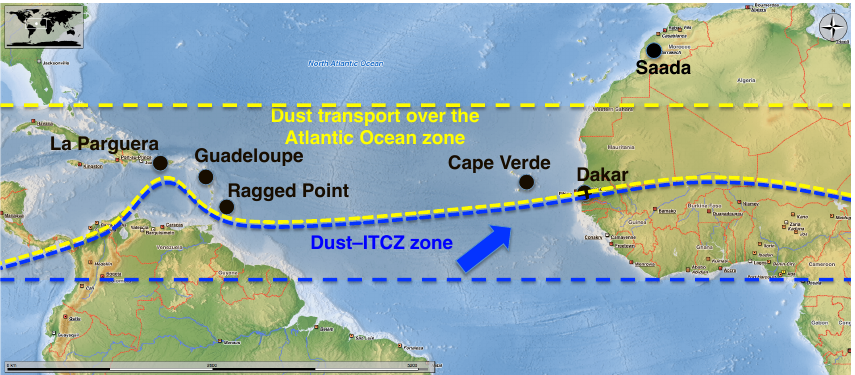
Figure 3. The locations of selected AERONET stations used in the transatlantic dust transport study. These include Saada, Cape Verde, and Dakar as western African stations and La Parguera, Guadeloupe, and Ragged Point as Caribbean stations. The upper blue line shows the approximate northern boundary of the ITCZ, and the yellow box indicates the adjacent dust transport region (DTA). The region within the blue boundaries represents the dust–ITCZ interaction zone (DIZ). These regions are defined according to the predominance of the dust removal mechanism shown in Fig. S1 in the Supplement.